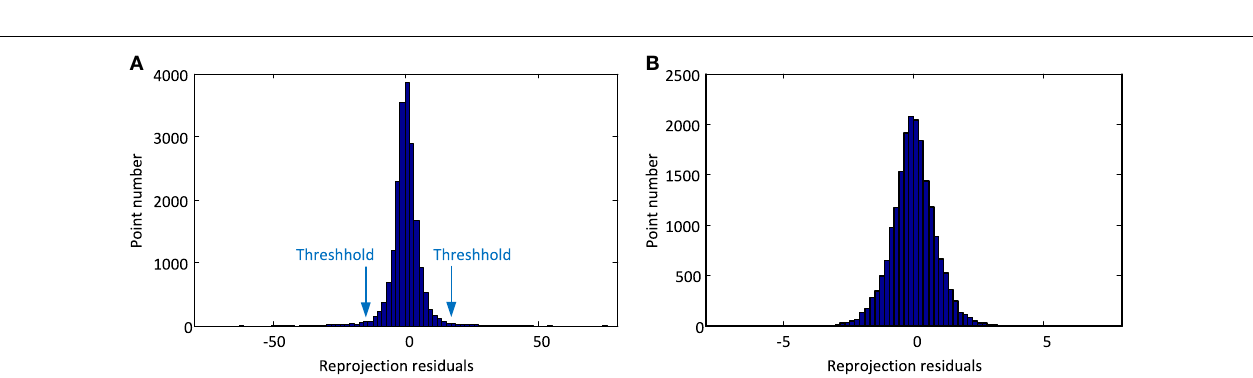
FIGURE 6 | The histogram distribution of the residual matrix of the dinosaur sequence before (A) and after (B) outlier rejection .